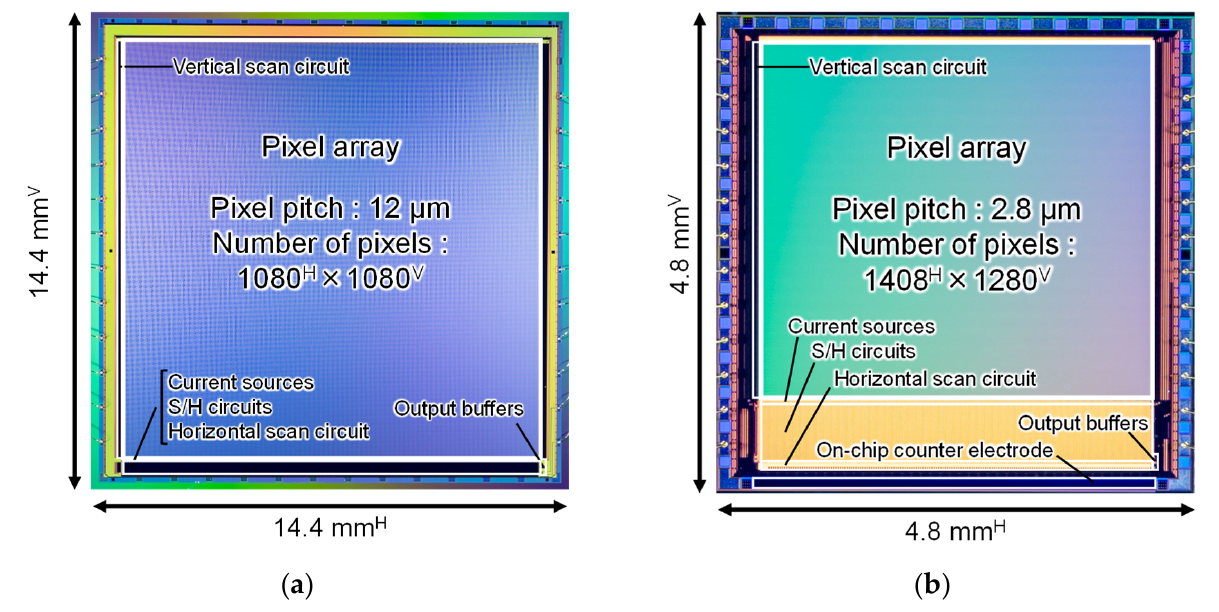
Figure 5. The micrograph of the fabricated CMOS proximity capacitance image sensors: ( a ) Chip A; ( b ) Chip B.